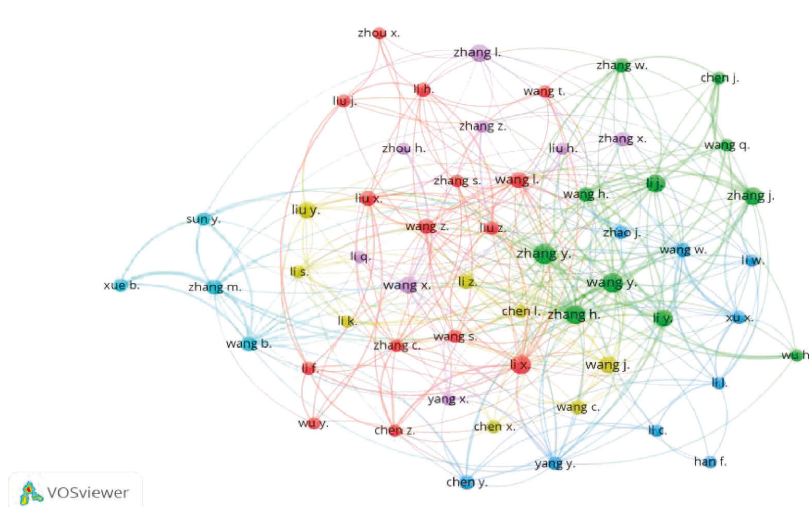
Figure 9: Network visualisation map for co-authorship on PSOA research.